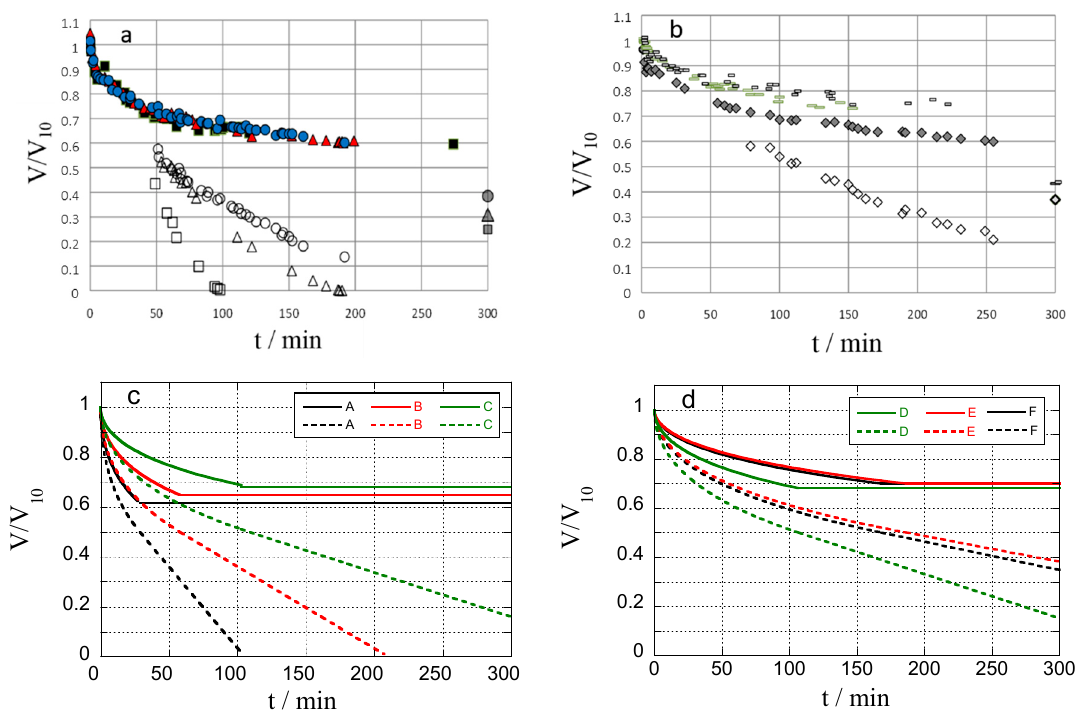
Figure 5. Relative volume ( V / V 10 ) of microgel and protein free gel core vs. time in lysozyme solution (NaCl/tris buffer; pH 8.0, I = 10 mM). ( a , b ): Experimental data for microgels A (squares), B (triangles) and C (circles) at C lys = 800 mg/mL, and D (diamonds), E (long rods), F(short rods) at C lys = 500 mg/mL. Predicted final volumes are arbitrarily positioned at 300 min in ( a , b ); ( c , d ): Theoretically calculated data for microgels A–F showing the gel volume (solid curve) and the core volume (dashed); curves are calculated by Equations (S12) and (S13) with input values of concentrations and microgel characteristics as in Table 1.